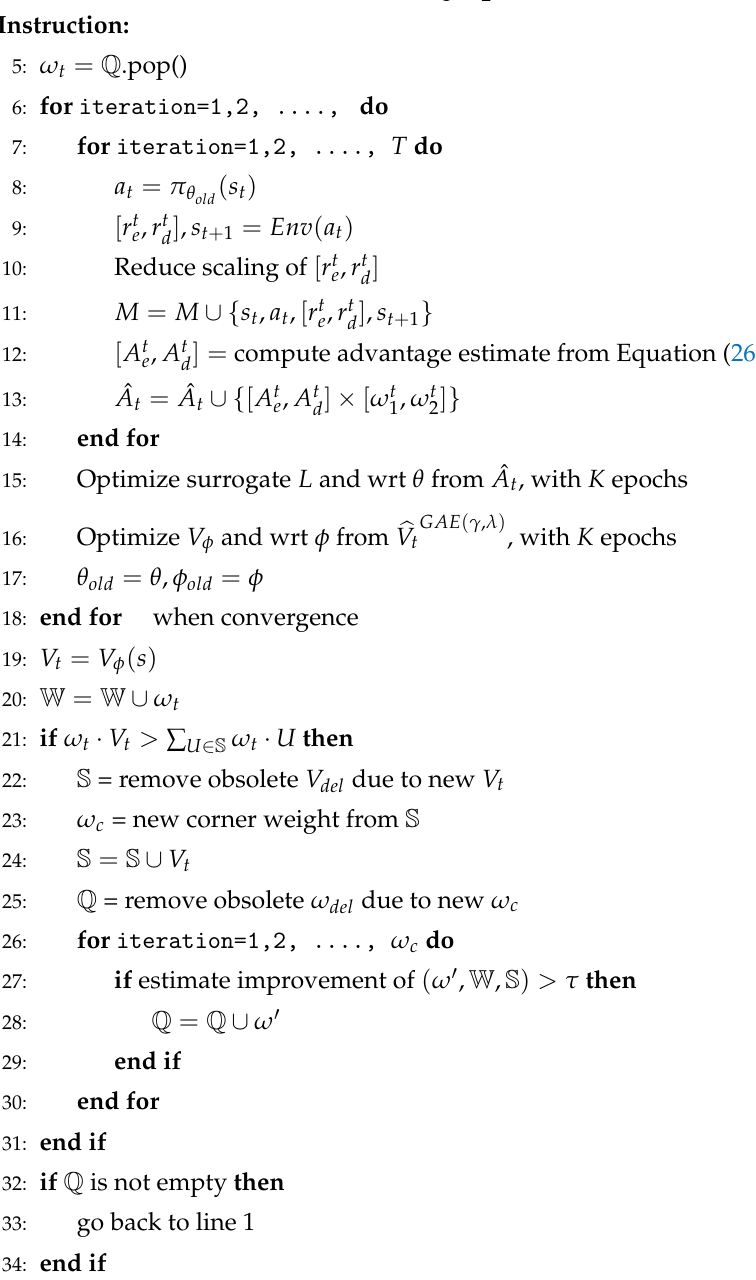
Algorithm 2 PPO-Based Deep Optimistic Linear